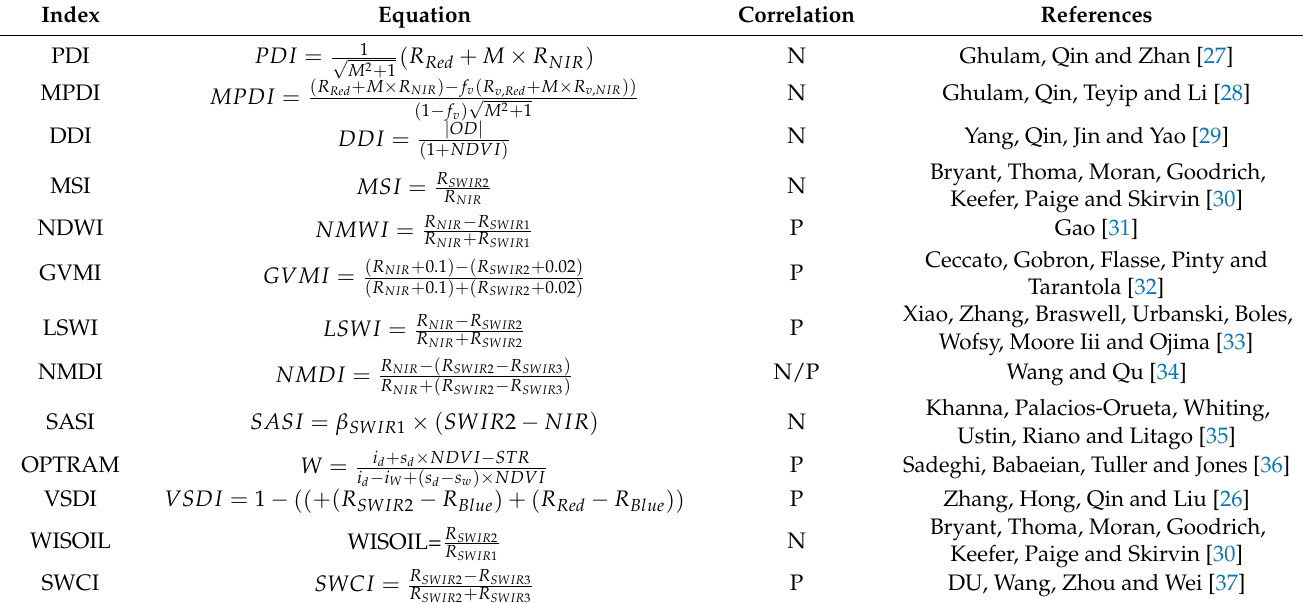
Table 2. The optical SM indexes used in this study and their correlation with